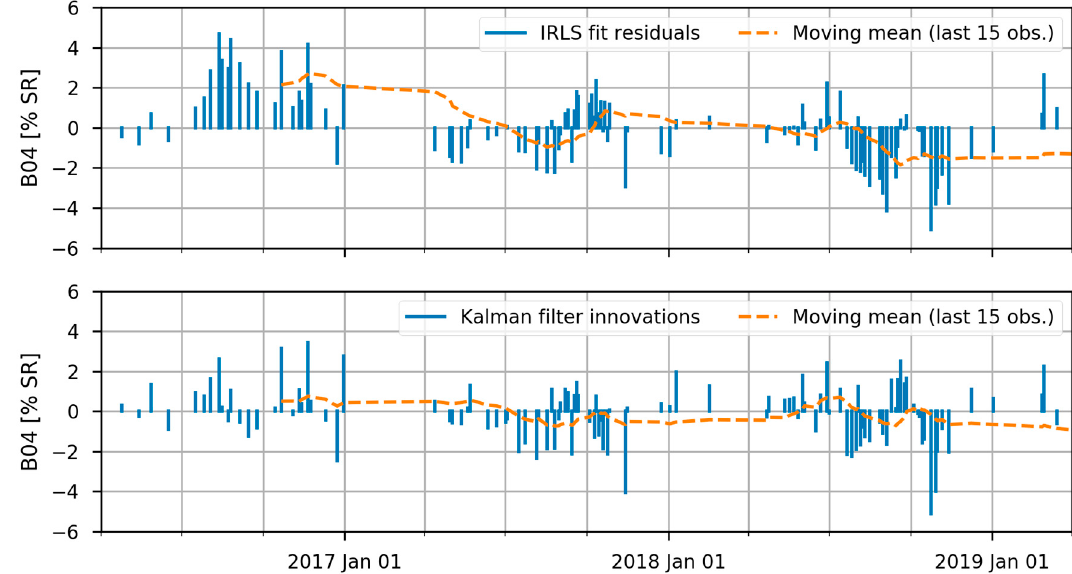
Figure 7. The residuals of the regression fit (IRLS) and the corresponding Kalman filter innovations for the same plot as in Figure 6. The orange dashed line represents the moving mean based on the last 15 observations.